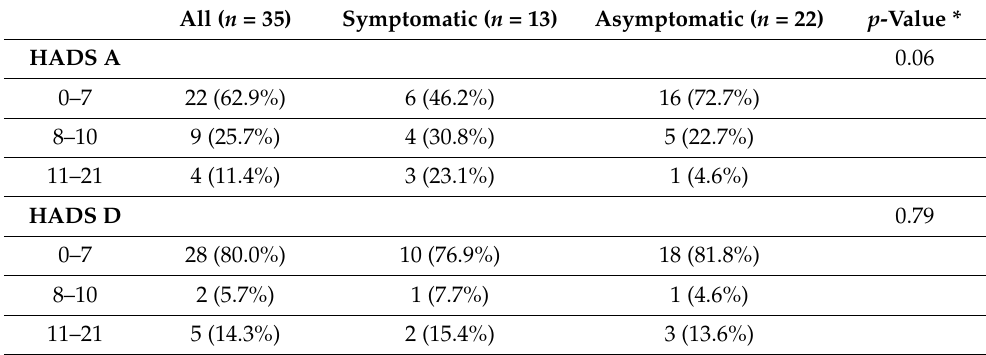
Table 3. Distribution of the severity of anxiety and depression symptoms according to the HADS scale in several